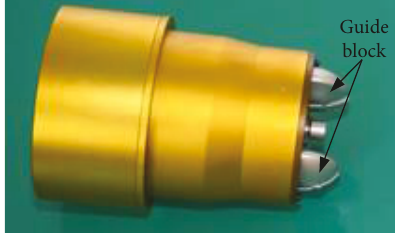
Figure 8: The end e ff ector prototype.